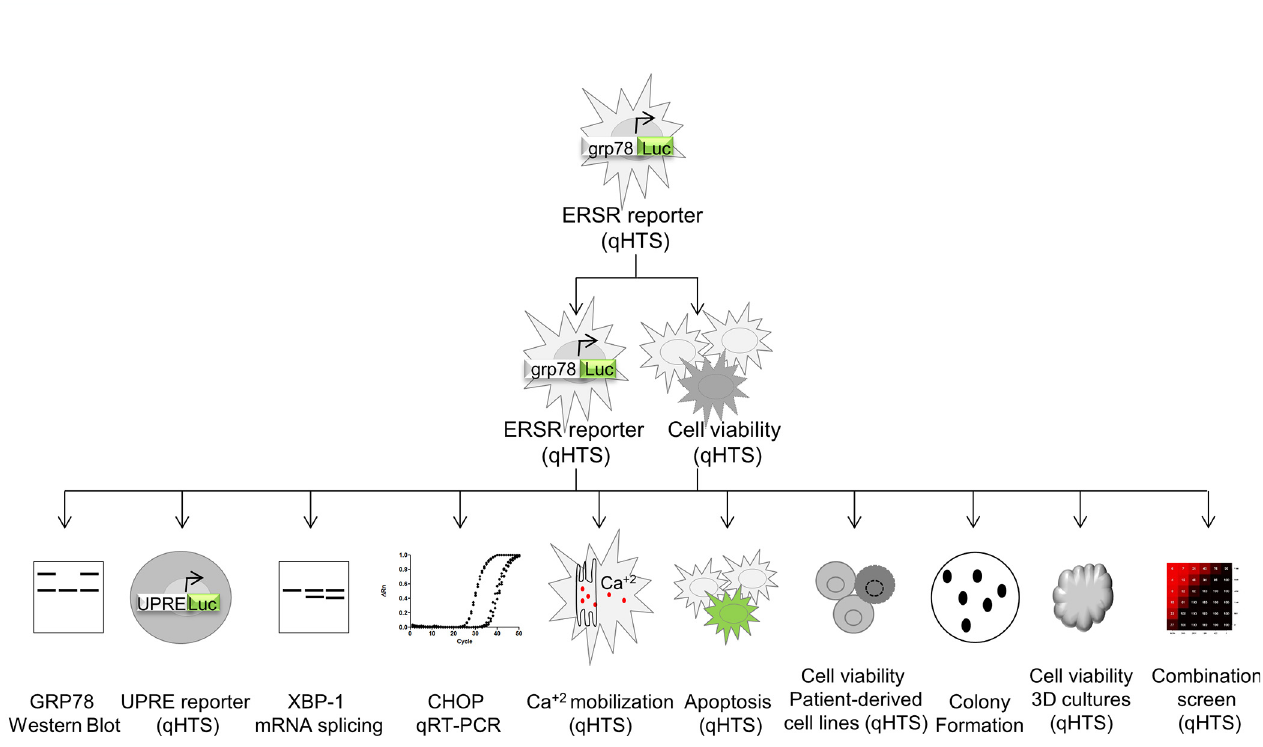
Fig 1. Schematic workflow for compound screening and triage. qHTS indicates assays performed in 1,536- and 384-well format. AC 50 obtained in qHTS assays are summarized in Fig 2. Results of remaining low-throughput assays are summarized in Fig 3.